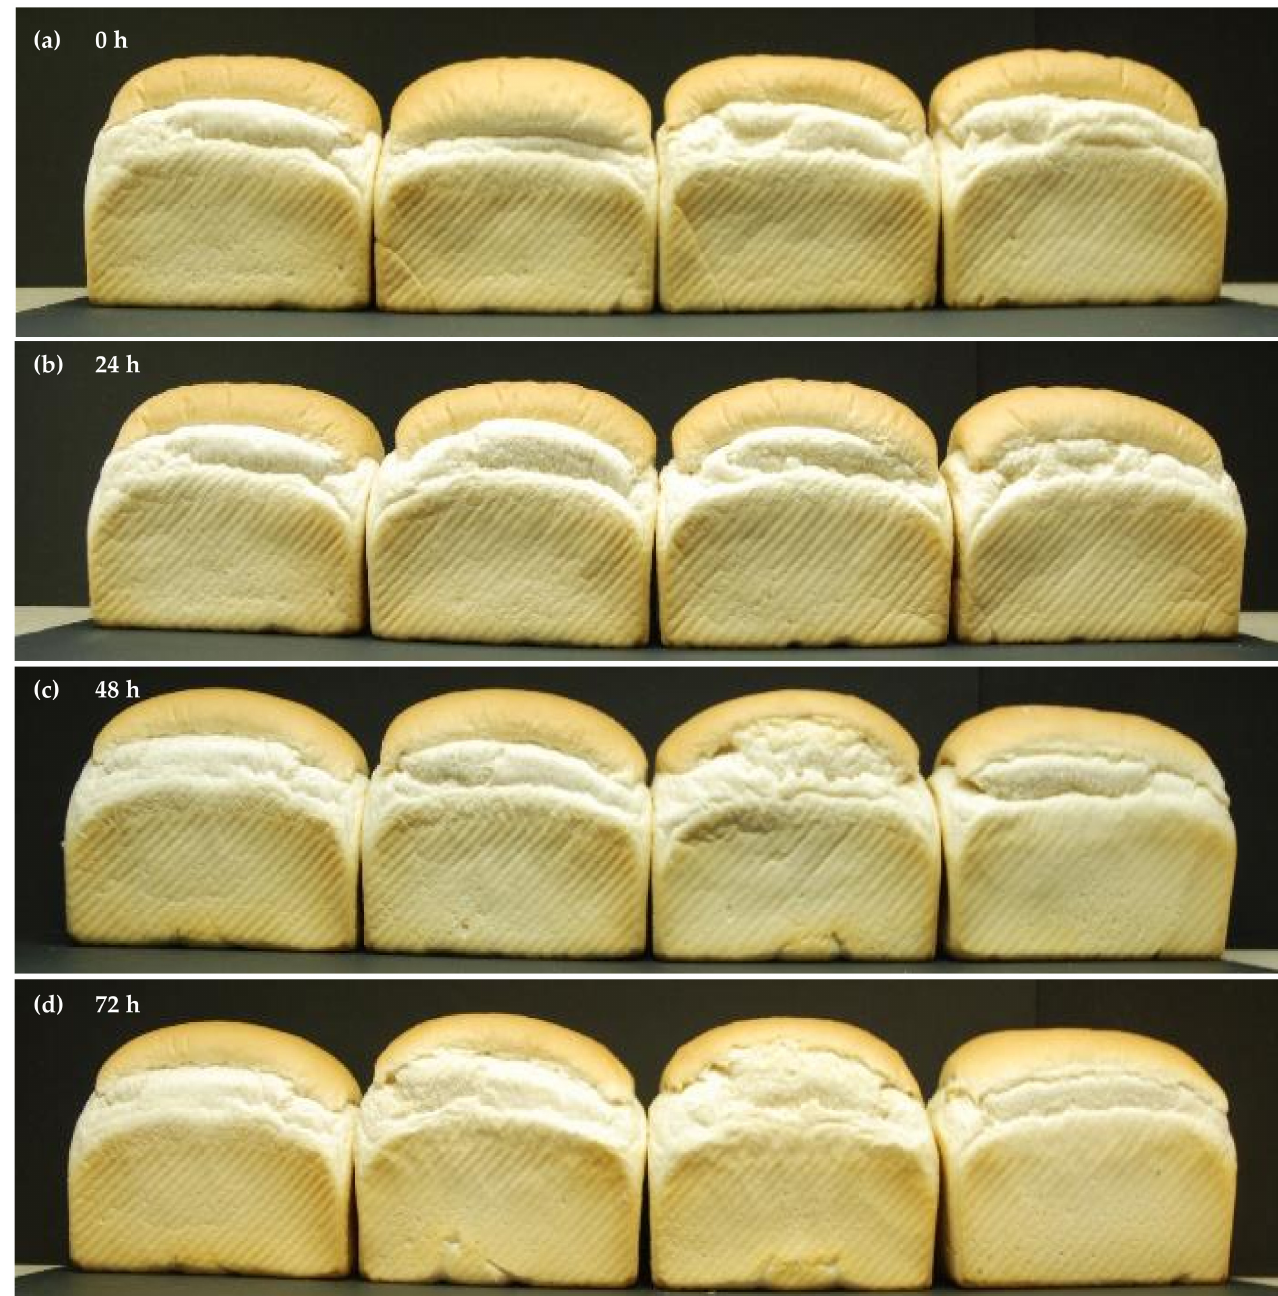
Figure 4. Breads made with fresh ferment and stored over a 72 h period. ( a ) 0 h of storage, ( b ) 24 h of storage, ( c ) 48 h of storage, and ( d ) 72 h of storage. Left to right: control (no ferment), 30% ferment inclusion, 50% ferment inclusion, and 70% ferment